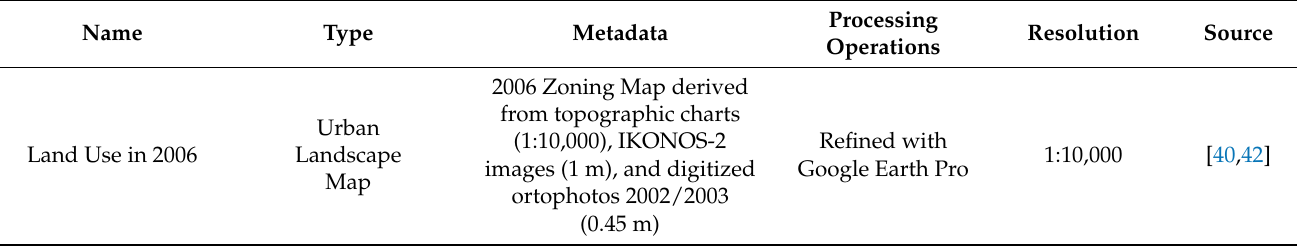
Table 2. Input data